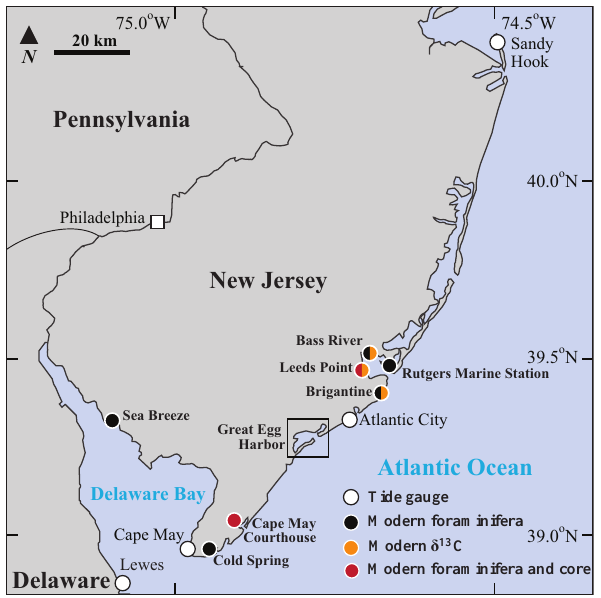
Figure 1. Location of study sites in southern New Jersey, USA. The distribution of modern foraminifera was described at 12 dif- ferent salt marshes including five in Great Egg Harbor (not located with symbols in the figure). Bulk surface sediment δ 13 C values were measured at three sites and cores for sea-level reconstruction (filled circles) were collected at Leeds Point and at Cape May